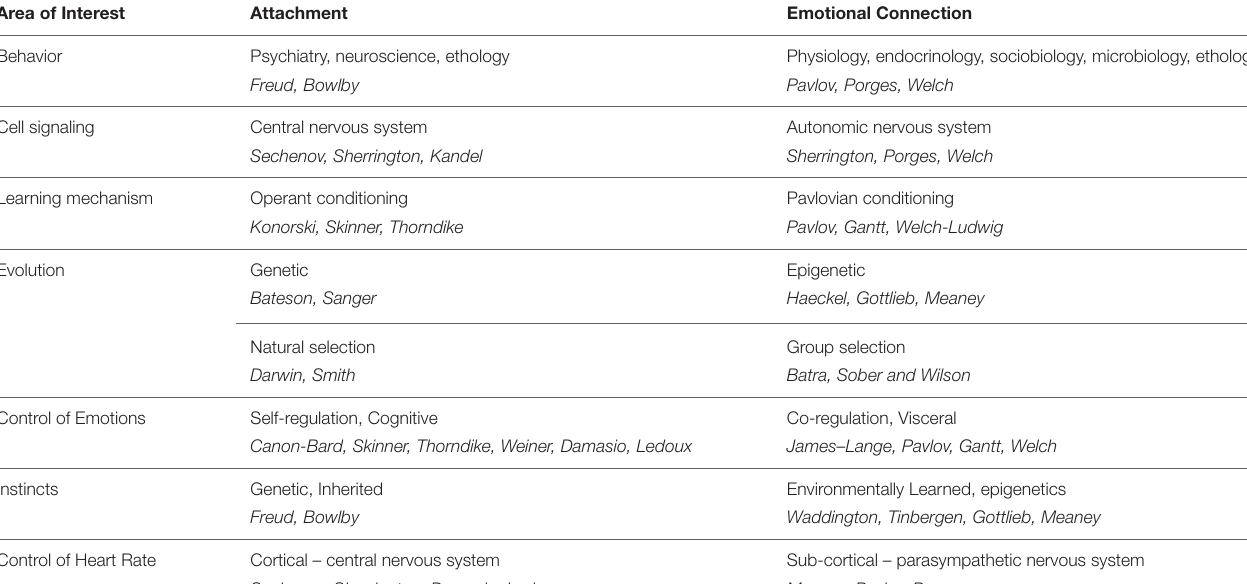
TABLE 2 | Comparison of theories supporting attachment and emotional connection by